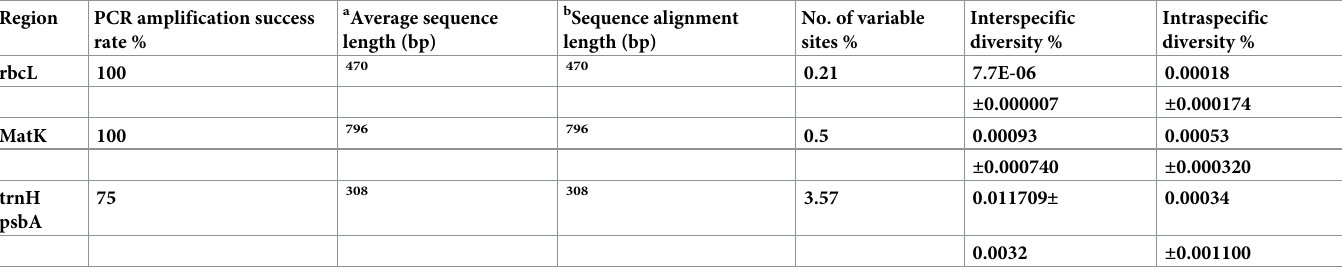
a length of sequencing data after trimming the noisy 5’ and 3’ ends b length after multiple